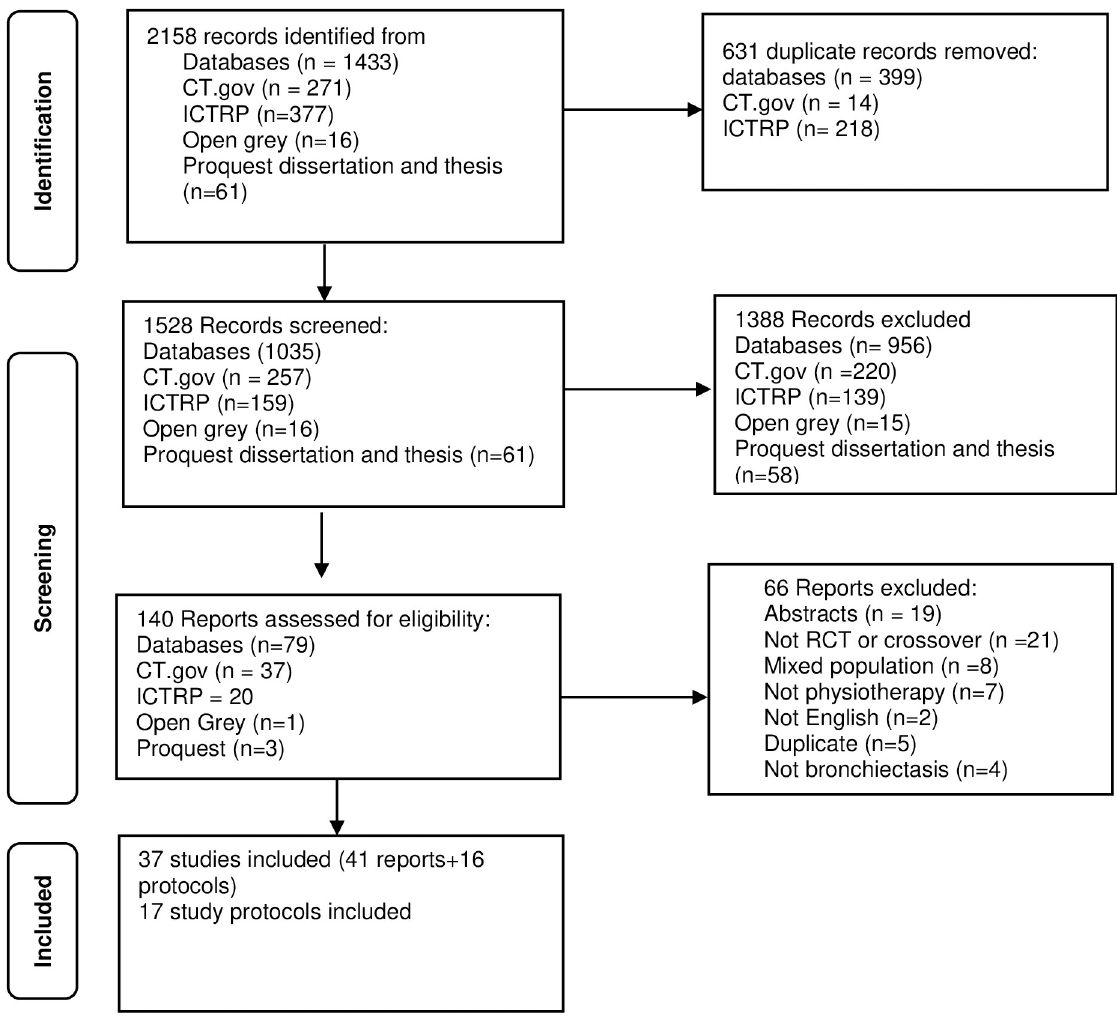
Fig 3. Frequency of outcomes reported per